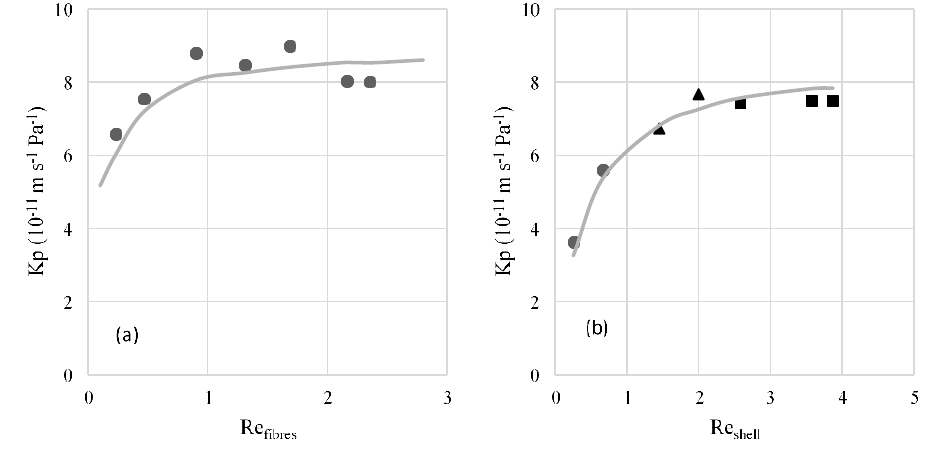
Figure 2. ( a ) Overall mass transfer coefficient ( K p ) as a function of Reynolds number (Re) in the fibres. Symbols represent the experimental data and line the data estimated by the correlation 𝑆ℎ = 0.6𝑅𝑒 1.0 𝑆𝑐 0.33 (𝑑 𝐿⁄ ) 0.33 ; ( b ) overall mass transfer coefficient ( K p ) as a function of Reynolds number in the shell. Symbols represent the experimental data obtained with different sucrose solutions circulating in the shell: ● 45% ( w / w ), ▲ 20% ( w / w ) ■ 10% ( w / w ). The line is the estimated data by the correlation 𝑆ℎ = 0.7(𝑅𝑒 𝑑ℎ/𝐿) 0.93 𝑆𝑐 0.33 .